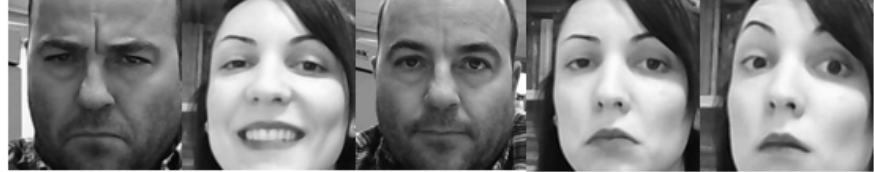
Figure 5. Emotion captures example, from video Dataset samples from our experiments. Representing 5 major